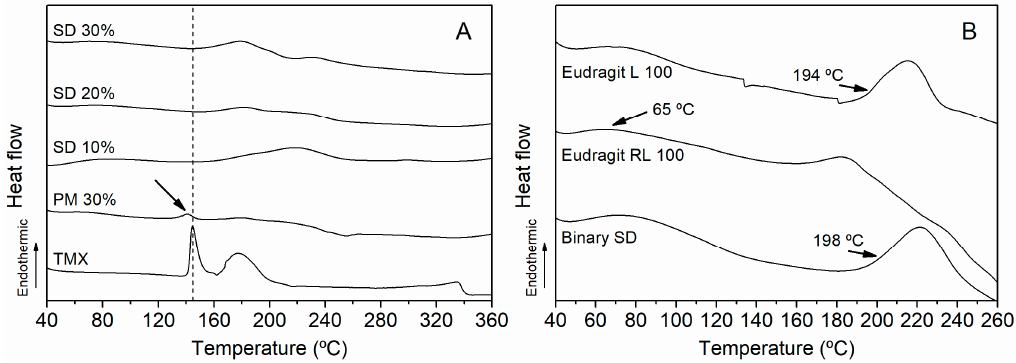
Figure 3. Differential scanning calorimetry (DSC) curves of ( A ) SDs, PM 30%, and isolated TMX, along with ( B ) Eudragit ® L 100 and Eudragit ® RL 100.